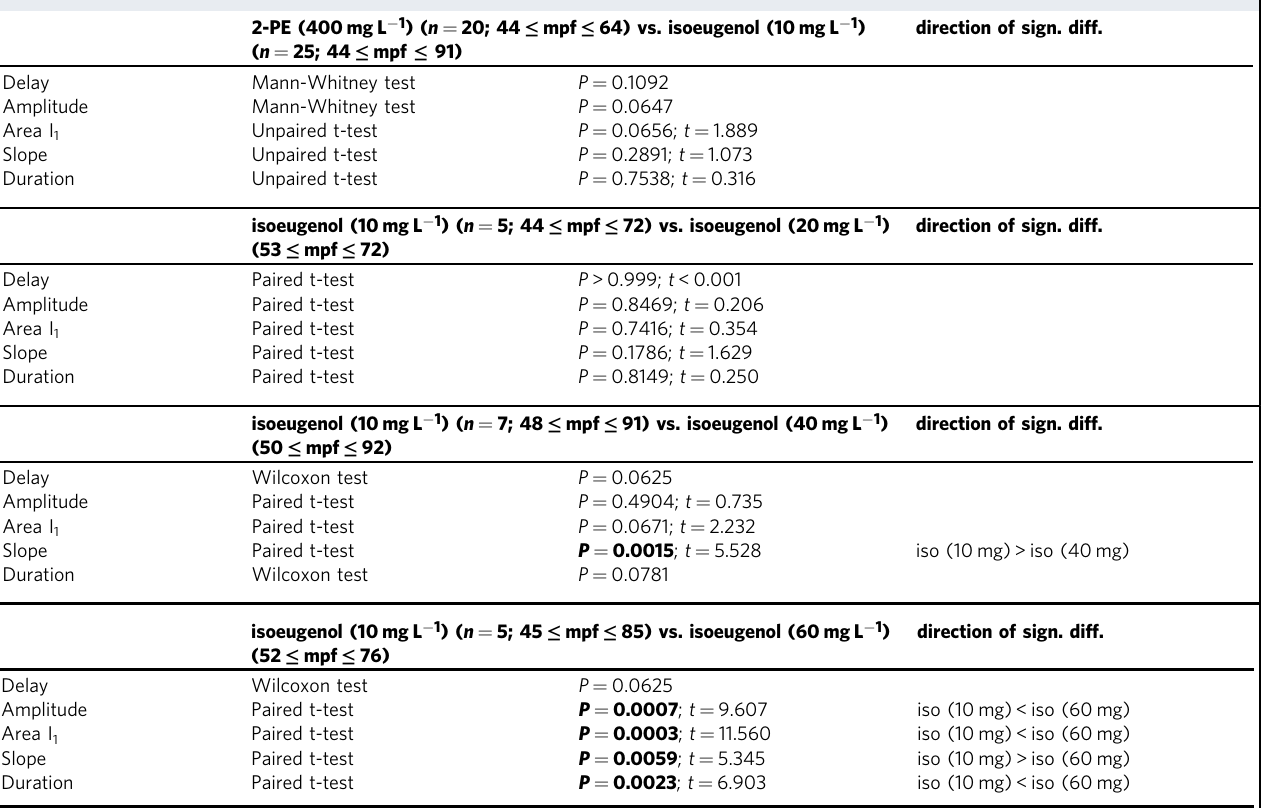
direction of sign.